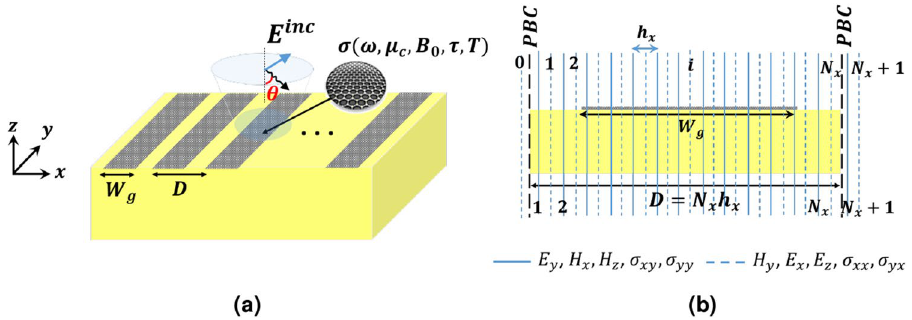
Figure 2. ( a ) Schematic of a PAMGS under illumination of an incident plane wave, ( b ) The discretized scheme of the PAMGS unit cell with periodic boundary